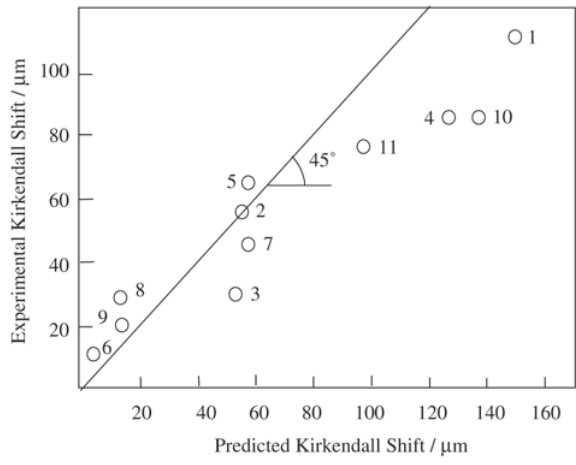
Figure 16. Comparison between the experimental and predicted Kirkendall shifts using the jump frequency model shown in Fig. 15 for various diffusion couples in the Cu-Ni-Zn system 44,45 .